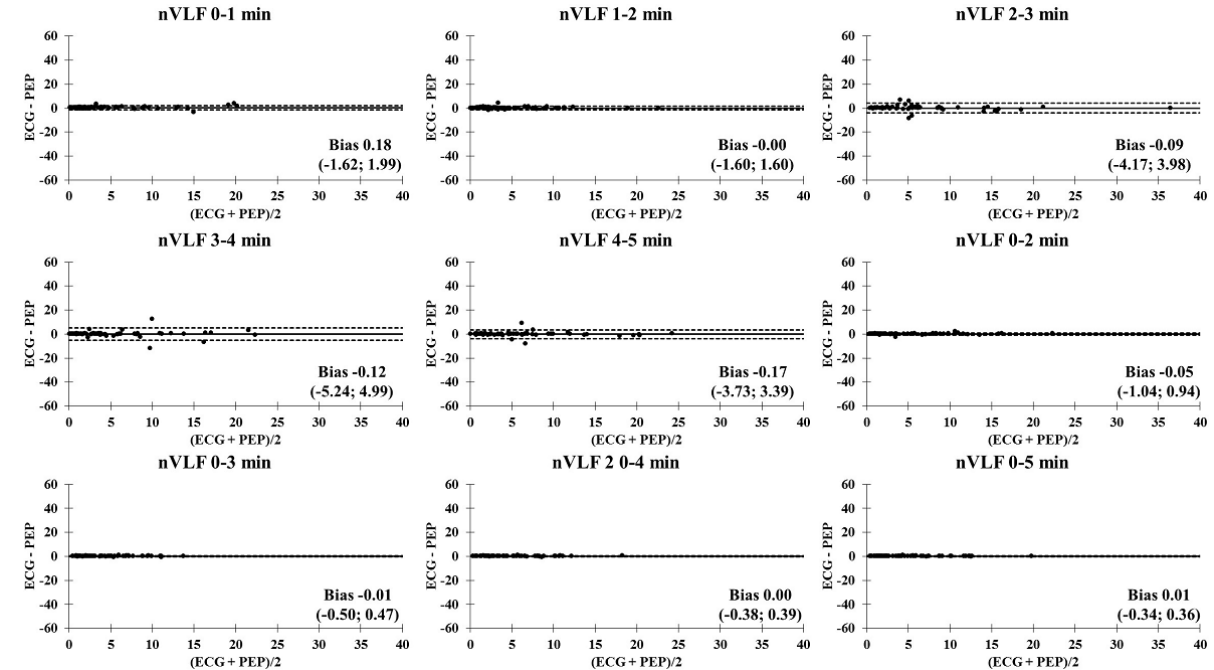
Figure 7. Bland-Altman analysis comparing the ECG and Pulse Express PRO measurements in ultra–short-term and short-term recordings of normalized very low frequency power (nVLF). The solid line represents the mean difference and the upper and lower dashed lines represent the upper and lower limits of agreement (± 1.96*SD). ECG: electrocardiogram; PEP: Pulse Express